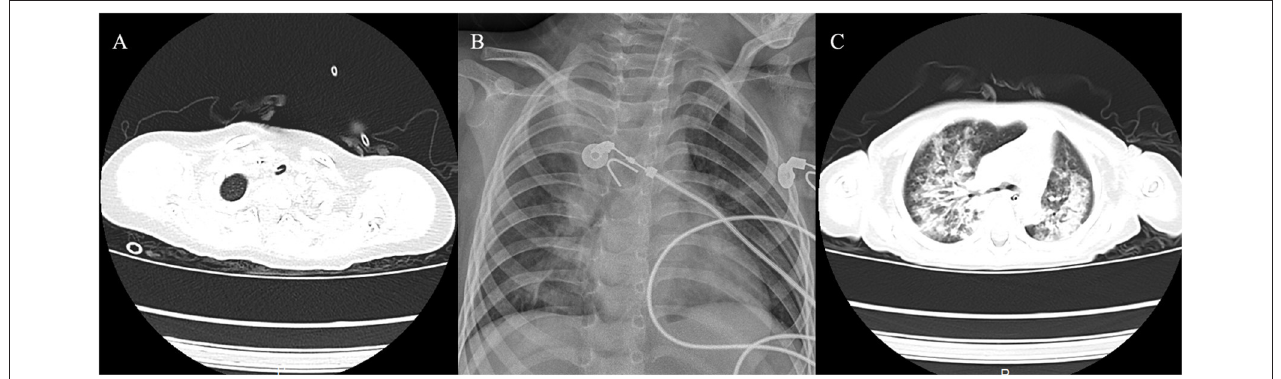
FIGURE 4 | Imaging findings of the three cases. (A) Case 1 showed membranous material that was strongly adherent to the tracheal wall. (B) Case 2 showed inflammation in bilateral lungs. (C) Case 3 had local stenosis of right main bronchus.